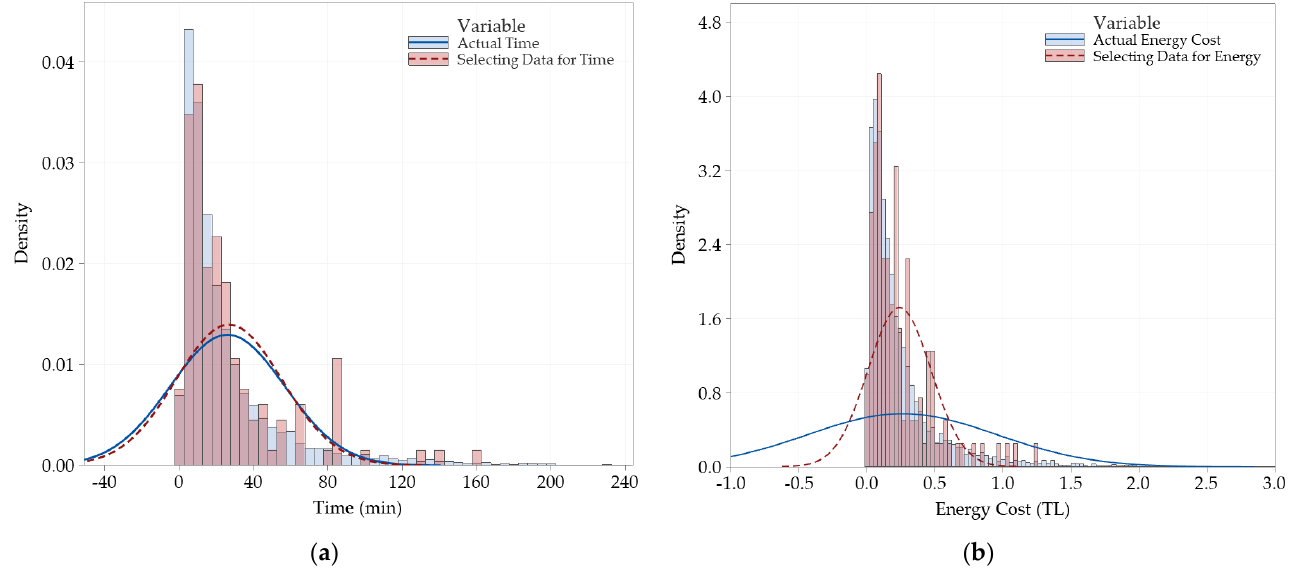
Figure 5. The testing data of ( a ) the delivery time output variable and ( b ) energy cost output variable.